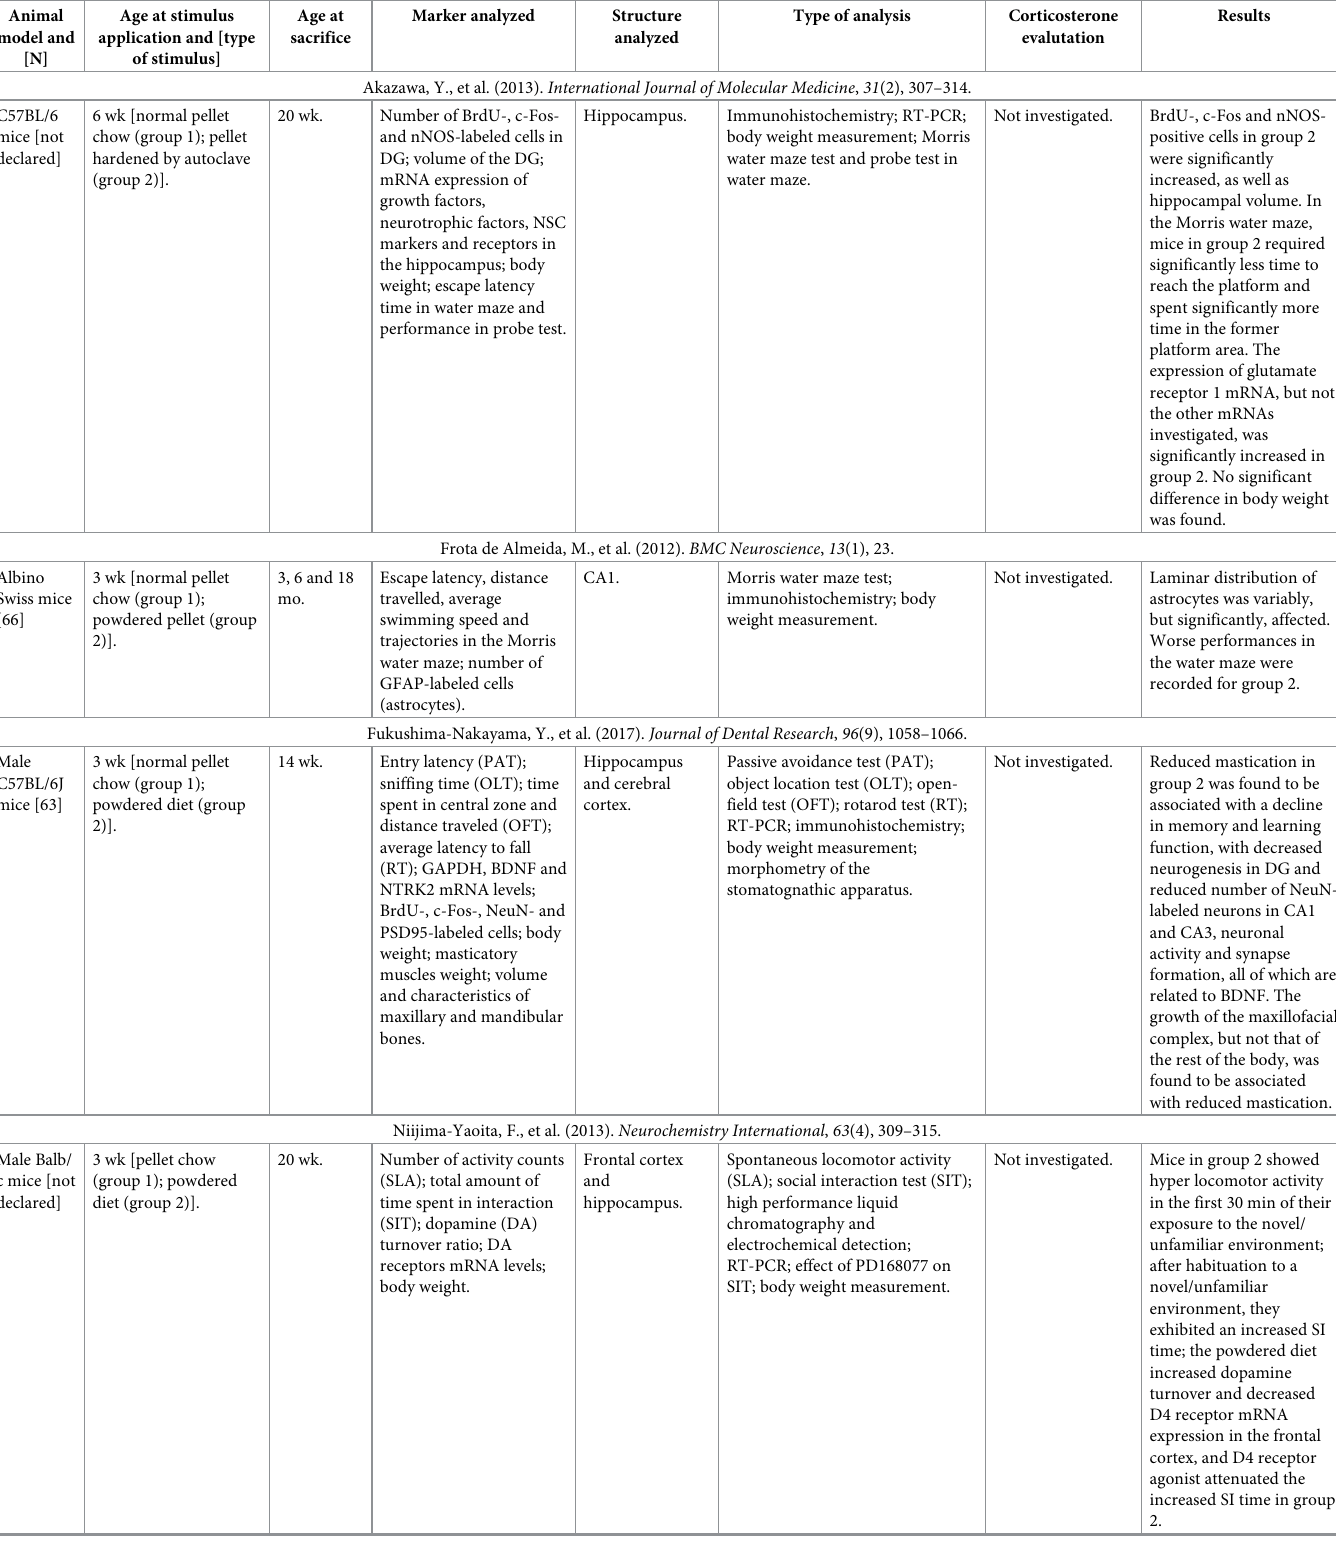
Table 3. Soft-diet